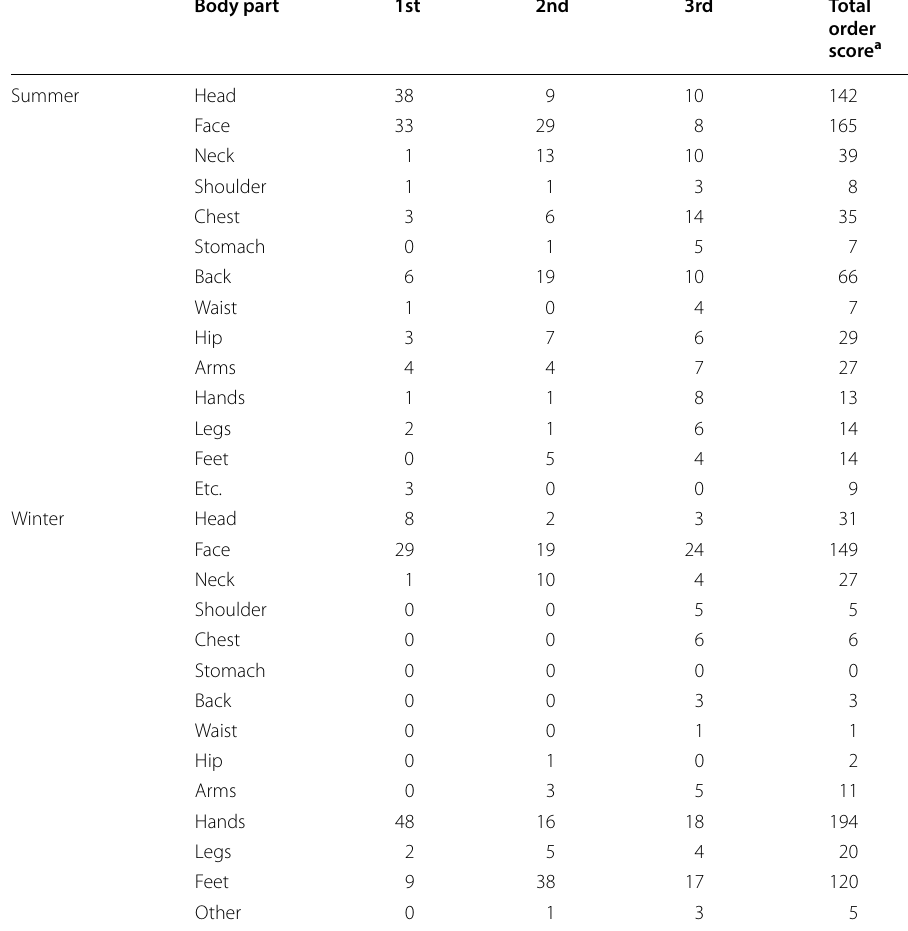
Table 5 Cold body parts in winter and hot body parts in summer (Unit: n,